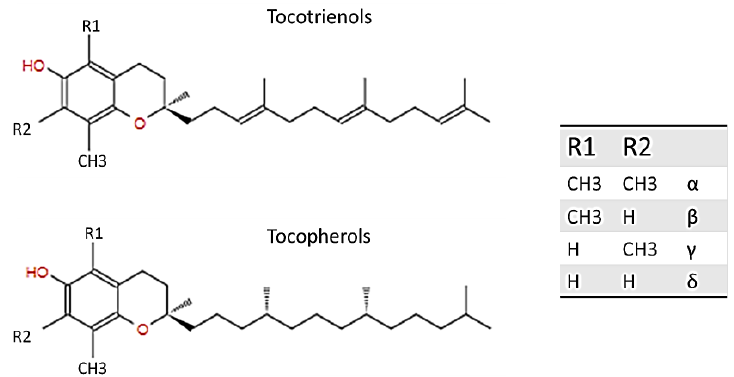
Figure 1. Structure of tocotrienol and tocopherol.